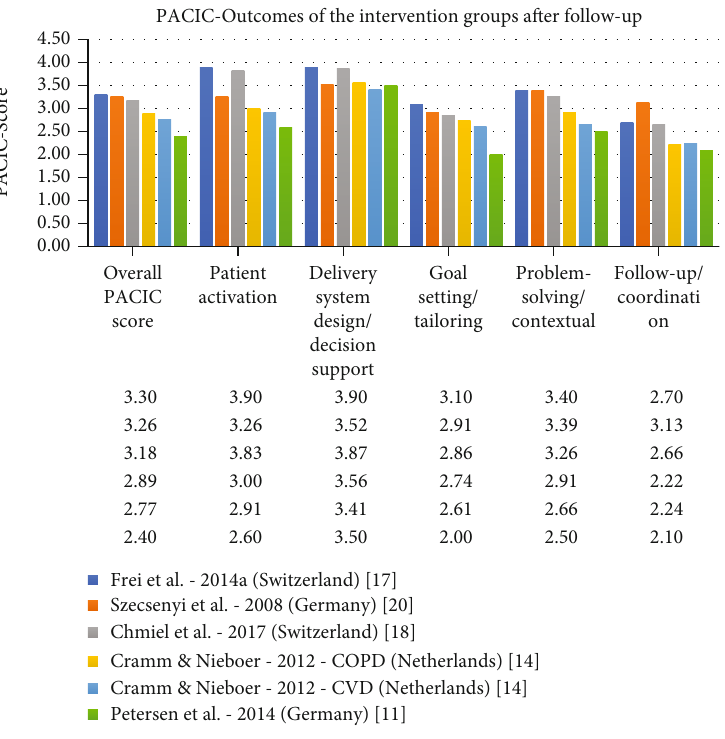
Figure 4: Comparison of the PACIC